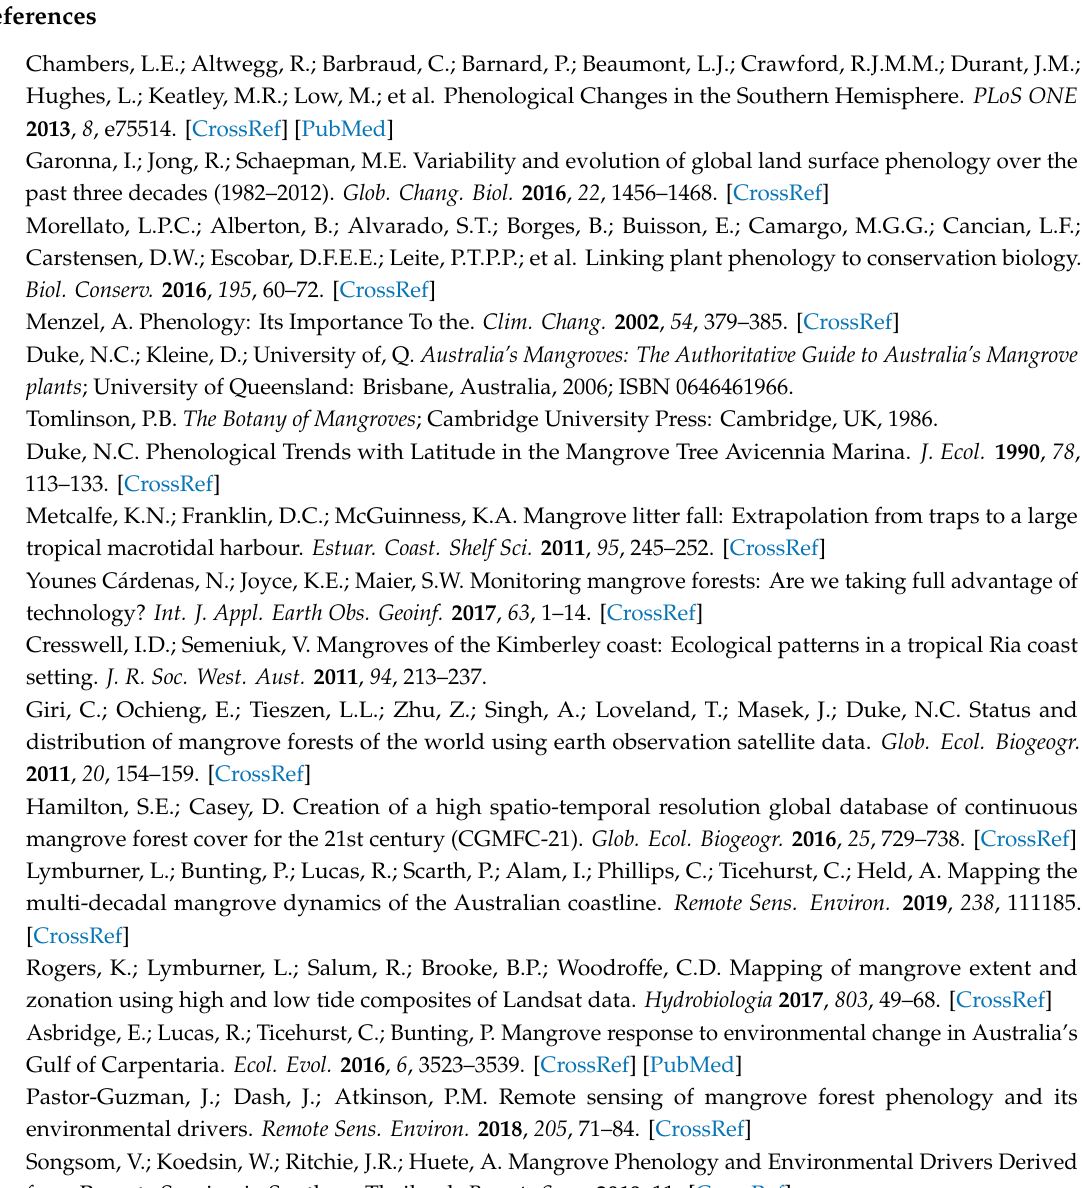
Figure S1: Observed EVI vs Apparent phenology for all sites, Figure S2: Mean Absolute error of the Cross-validation predictions of